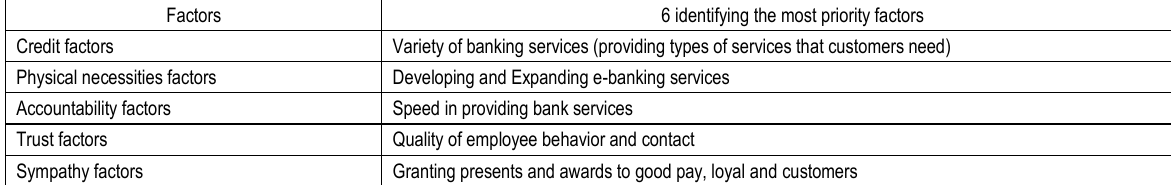
Table 23. Identifying the most priority hypothesis